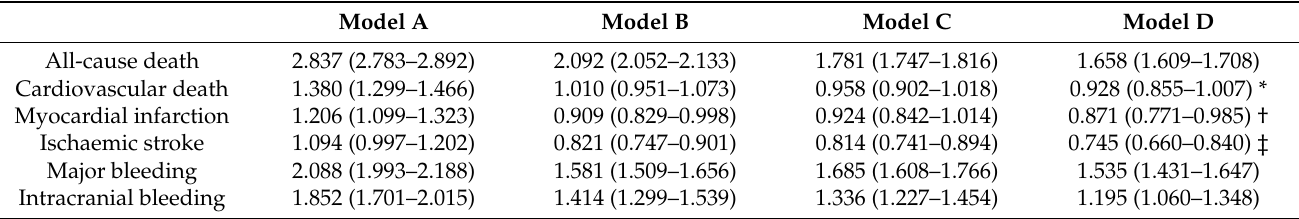
Table 4. Hazard ratios associated with multiple myeloma (vs without) for incident outcomes.